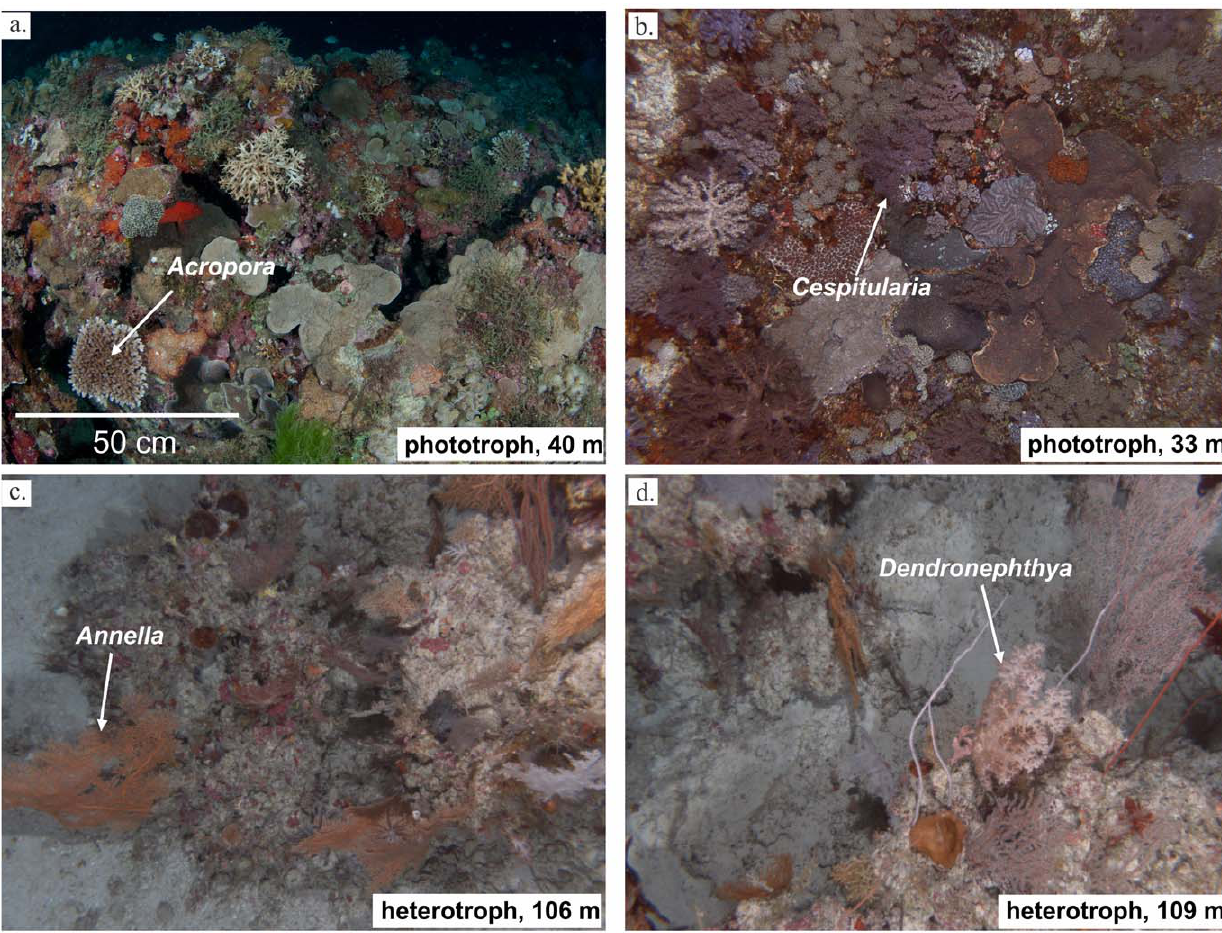
Figure 2. Examples of phototrophic and heterotrophic mesophotic communities on the Great Barrier Reef. Phototrophic communities shown in (a), (b), and heterotrophy communities in (c), (d). Photo (a) by Ed Robert at Mantis Reef, (b), (c) and (d) taken by Sirius autonomous underwater vehicle (Australian Centre for Field Robotics) at Hydrographers Passage.